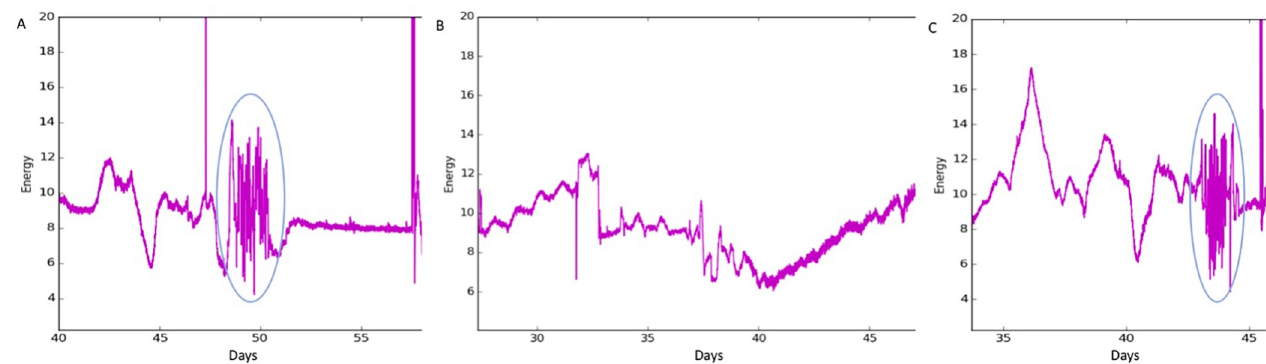
Fig 4. TurtleSense activity readings for in situ fertile and infertile nests during the 2016 nesting season in Cape Hatteras National Seashore, NC. A) A typical fertile nest has a long initial incubation period, followed by tightly clustered hatching activity and a posthatch period before emergence. TurtleSense detected hatching in this nest from day 47.5–50.5. A depression was observed on Day 50. Emergence was noted as a boil on Day 53, followed by 6 more turtles emerging on Day 56. Nest excavation found 92 hatchlings had successfully left the nest, 5 alive hatchlings, and 7 unhatched eggs (Day 57). Circle indicates hatching activity. B) This infertile nest was overwashed multiple times (Days 31–38) and had a significant amount of sand accumulation on the nest. Sensor data never detected hatching activity and is typical of data seen in a nonviable nest. Early nest excavation due to impending tropical storm Hermine found the nest to be dead with 117 unhatched eggs (Day 47). C) This nest hatched early and so did not yet have nest expansion protections. There was no depression and no turtles had emerged, but sensor activity detected completed hatching activity (Day 43–44). In response to the TurtleSense data and impending tropical storm Hermine, this nest was excavated early (Day 46) to reveal 86 live hatchlings near the surface of the nest cavity, which were subsequently released. There were also 11 unhatched eggs.